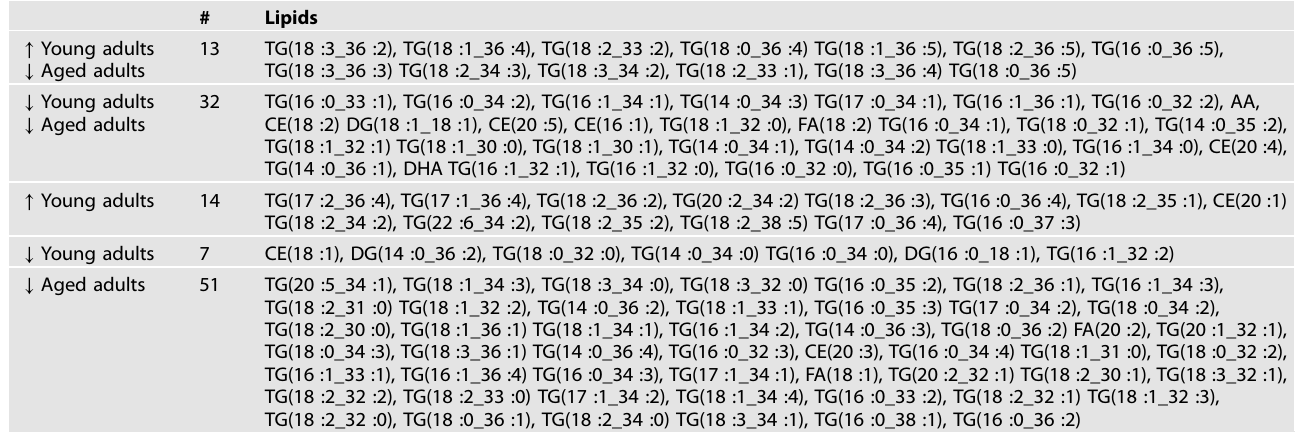
At 7 dpi, lipids signi fi cantly increased upon infection in young-adult but decreased in aged hamsters ( n = 13), lipids signi fi cantly decreased upon infection in both age groups ( n = 32), lipids signi fi cantly increased upon infection in young-adult hamsters only ( n = 14), lipids signi fi cantly decreased upon infection in young-adult hamsters only ( n = 7), and lipids signi fi cantly decreased upon infection in aged hamsters only ( n = 51). Fold change >0.5, P <